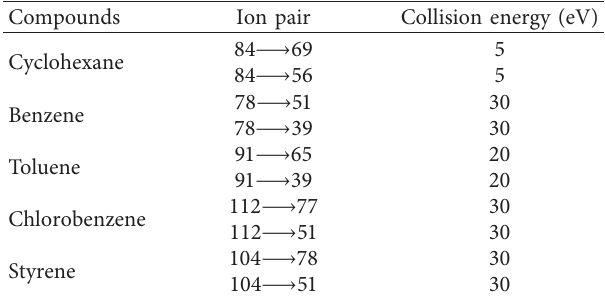
Table 1: MRM parameters of the five volatile organic compounds to be